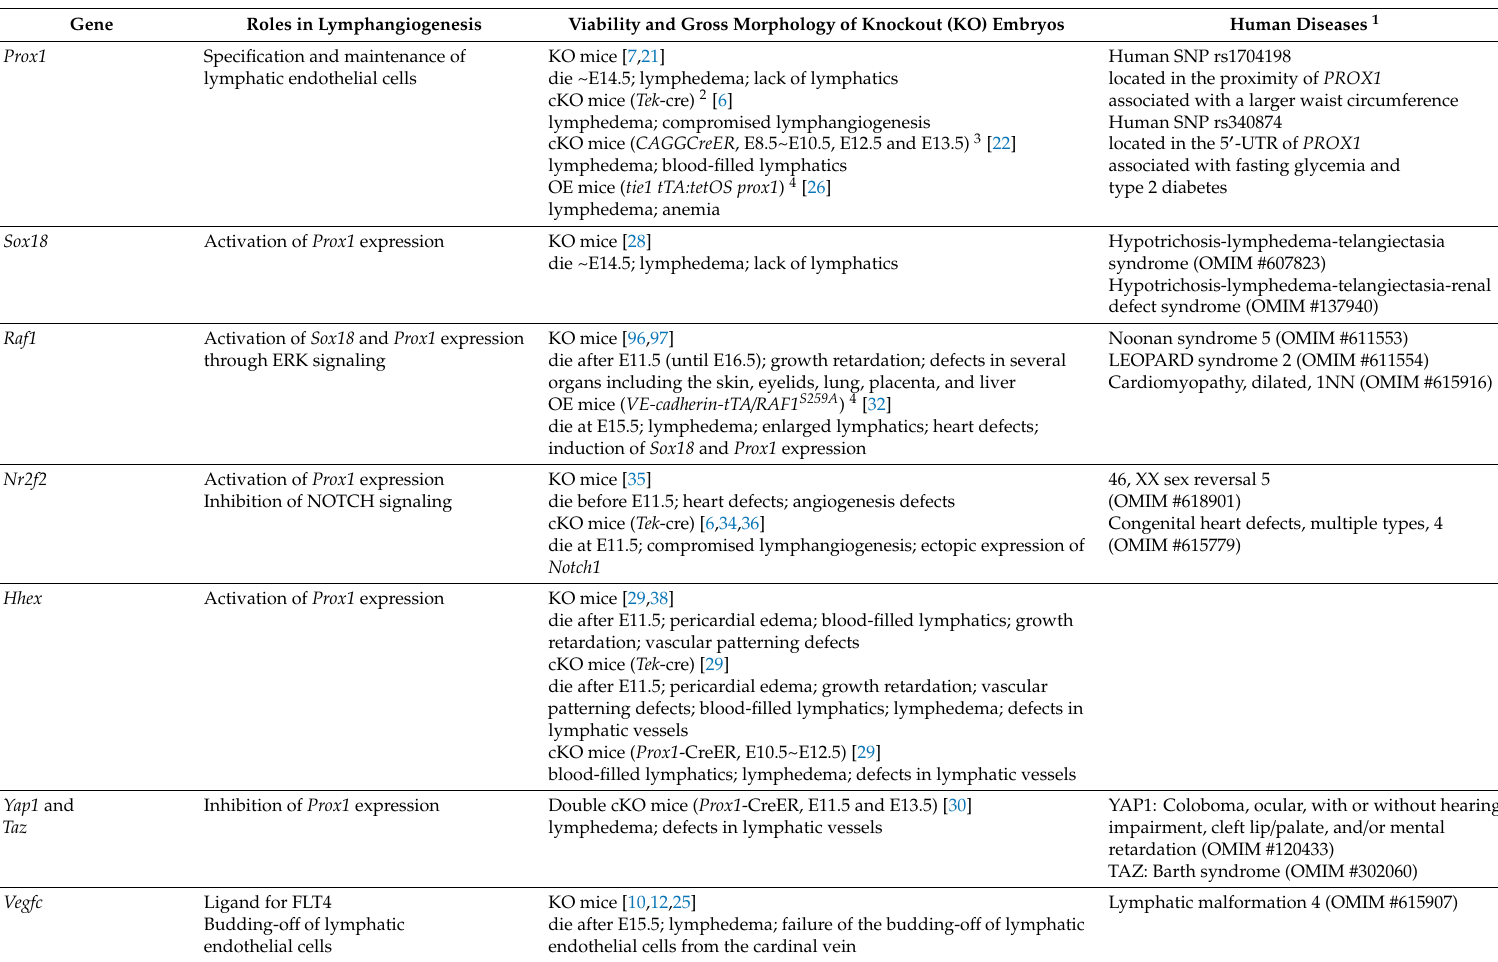
Table 1. Mouse models of genes involved in the cell fate determination of lymphatic endothelial